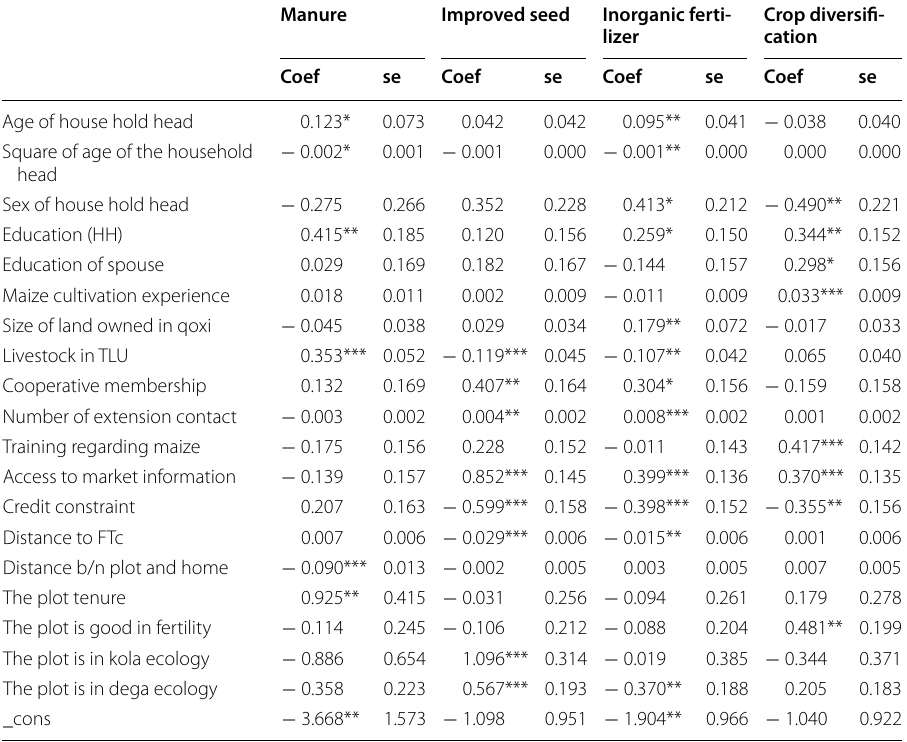
Table 6 Multivariate probit simulation results for households’ technology adoption deci- sions without Mundlak’s